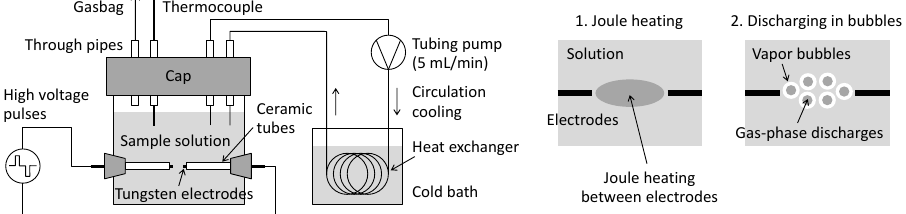
Figure 1. Schematic diagram of the reactor and the mechanism of solution-plasma generation.